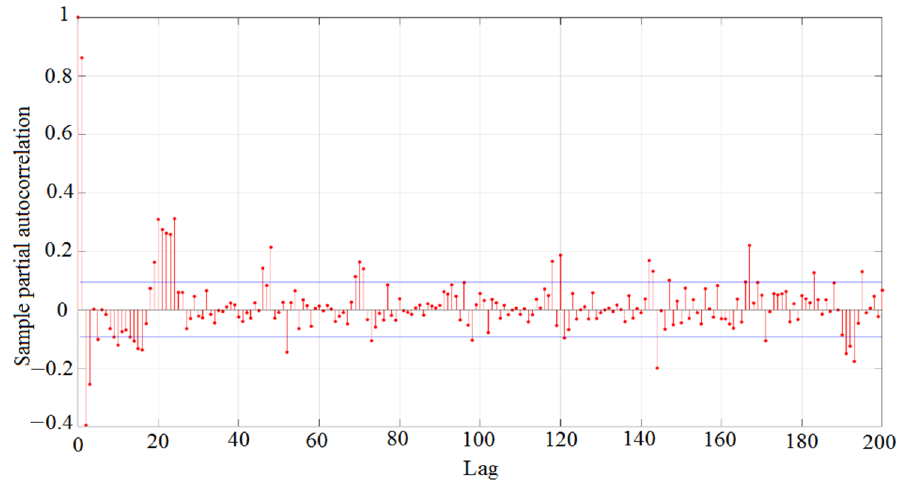
Figure 6. Partial Autocorrelation Function ( PACF) plot for household PV output system within unclear sky days.